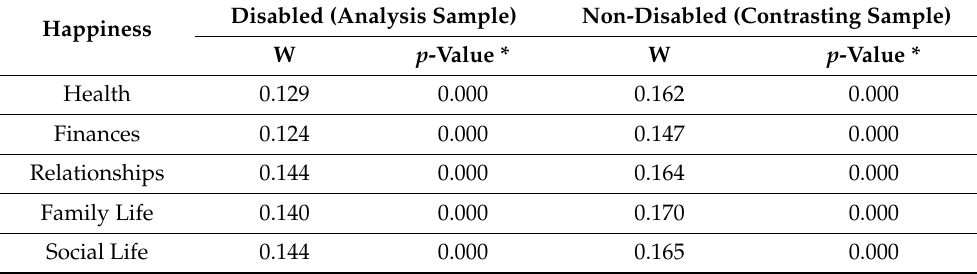
Table 4. Kolmogorov-Smirnov Test